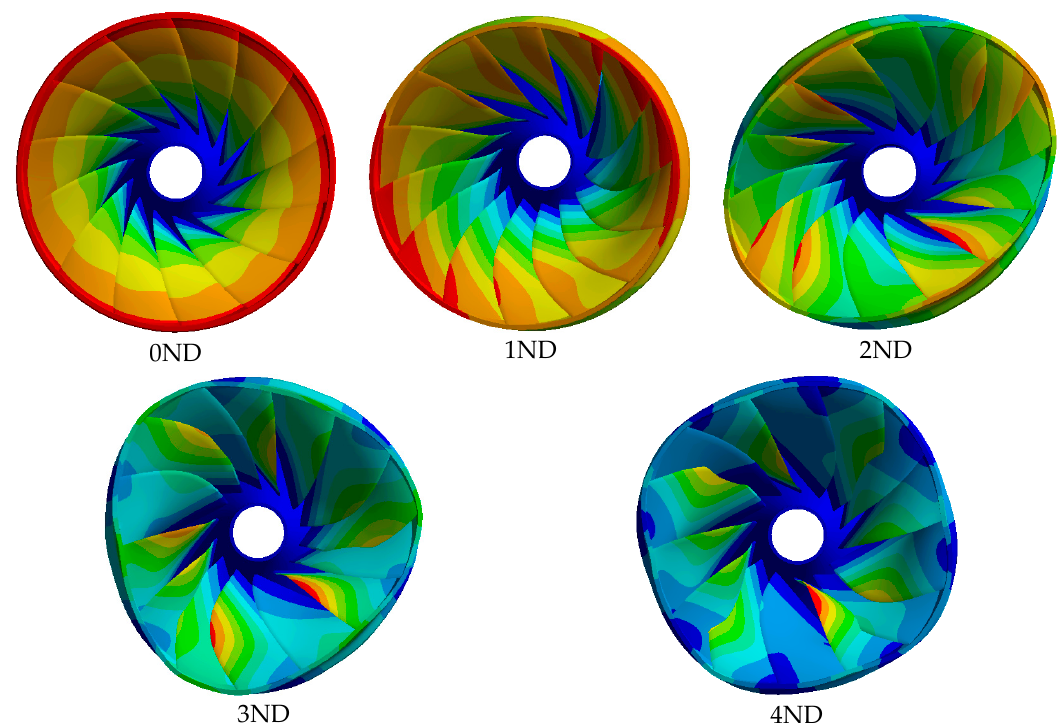
Figure 5. First mode shapes obtained with the FSI numerical situation. Bottom view. XND, X-nodal diameters.